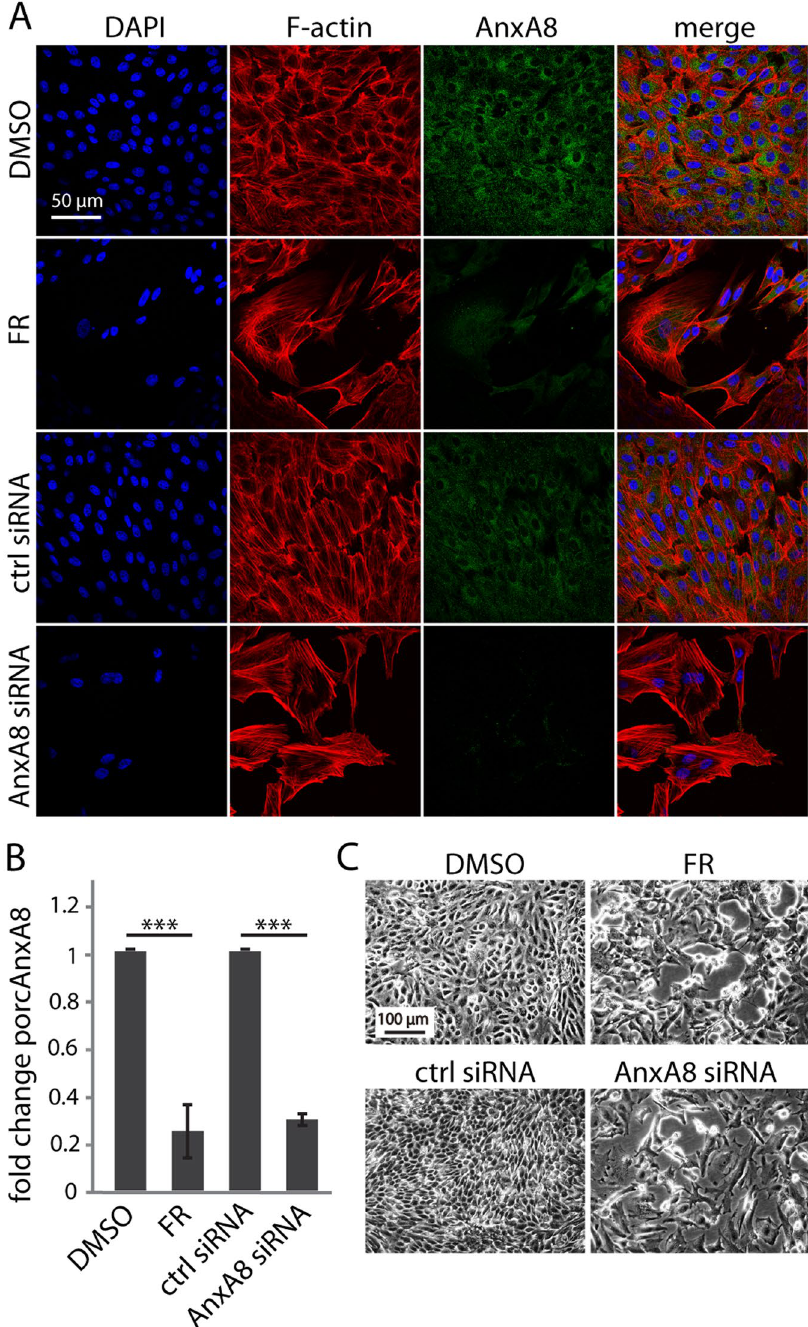
Figure 2. Primary porcine RPE respond to FR and AnxA8 siRNA in the same way as ARPE-19 cells. ( A ) FR and AnxA8 siRNA treatment for 7 days results in fewer cells (DAPI, blue), formation of cytoplasmic extensions and F-actin rich domains at the cell borders (rhodamine phalloidin, red) with concomitant down-regulation of AnxA8 (green). Scale bar = 50 μ m. Shown are representative immunofluorescence images from 3 independent experiments. ( B ) Cell lysates were prepared under each of the conditions shown in ( A ) and AnxA8 siRNA levels were quantified by real-time PCR. Similar to ARPE-19 cells, porcine AnxA8 mRNA transcripts were down- regulated in the presence of FR and AnxA8 siRNA. Data show mean and standard error from 5 independent experiments. Student’s t-test was used to calculate statistical significance ( *** = P < 0.001). ( C ) Representative phase images show that FR and AnxA8 siRNA treatment both lead to extension formation and suppression of cell growth as observed in ARPE-19 cells. Scale bar = 100 μ